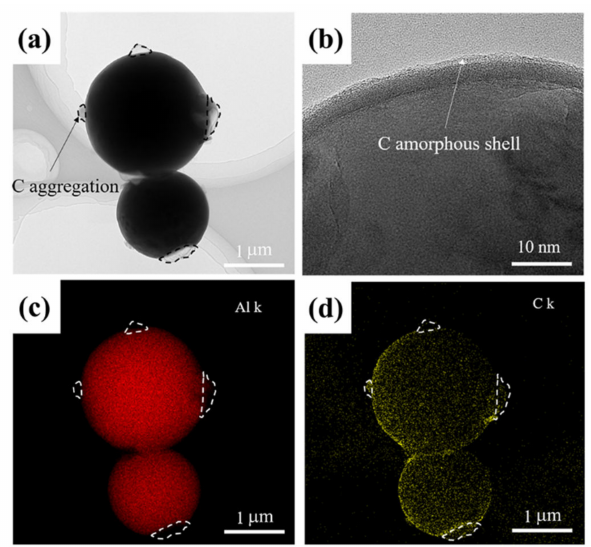
Figure 3. TEM images and EDS maps of the Al particles modified by 3 wt.% PVB: ( a ) TEM image of the Al powder modified by PVB after degradation, ( b ) HRTEM image of the modified Al surface, and ( c ) and ( d ) EDS mapping of the Al and C distribution.